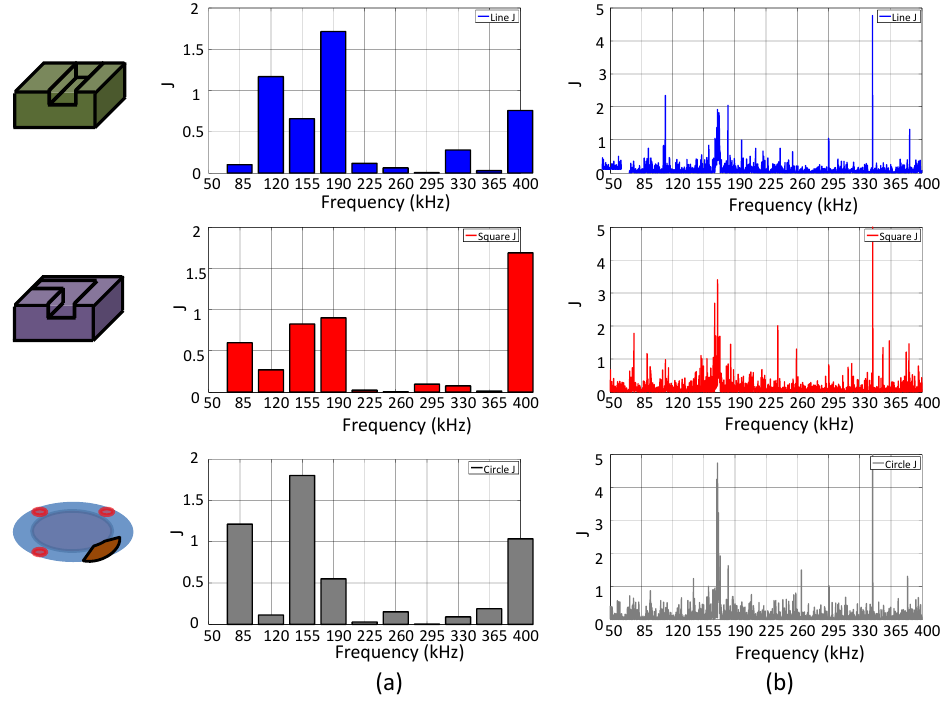
Figure 17. Classification index J with various bandwidth sizes: ( a ) 36 kHz; ( b ) 150 Hz.